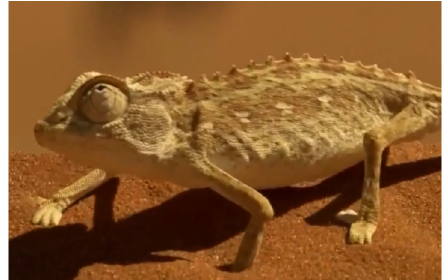
Figure 1. Desert chameleon.